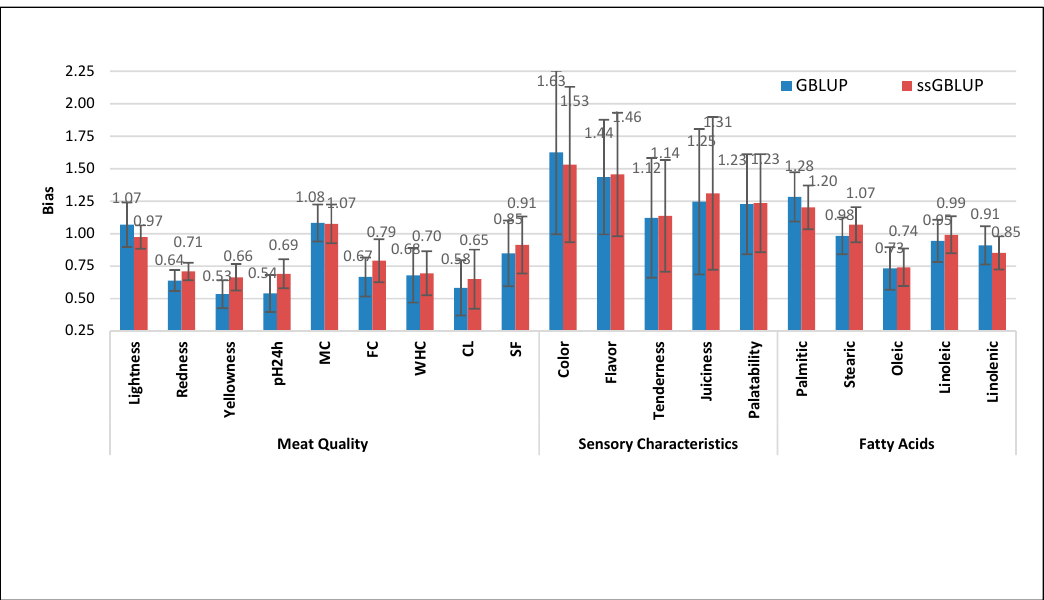
Figure 4. Bias estimates and standard error obtained using GBLUP and ssGBLUP for meat quality traits, sensory characteristics, and fatty-acid composition of Duroc meat. pH24h—pH at 24 h post-mortem; MC—moisture content; FC—fat content; WHC—water-holding capacity; CL—cooking loss; SF—shear force.